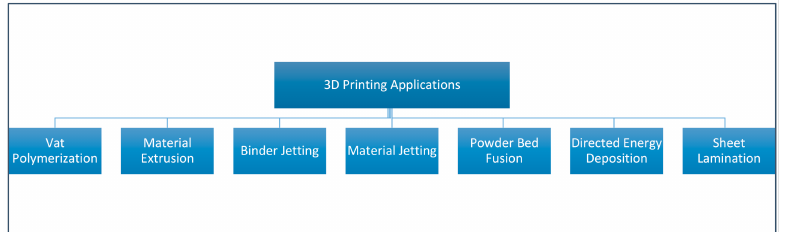
Figure 2. Overview of the various 3D printing applications, based on the subdivision of ISO